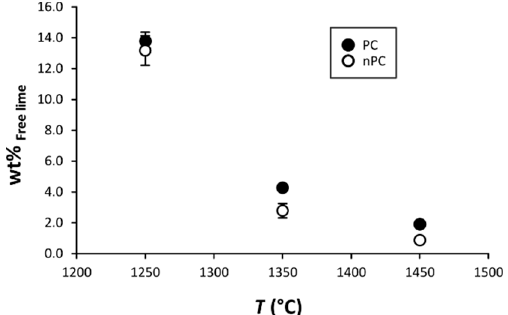
Figure 12. Binary plot free lime vs. T . The free lime content after clinker burning is given as CaO + Ca(OH) 2 . If not present, error bars in wt % are within the symbols.